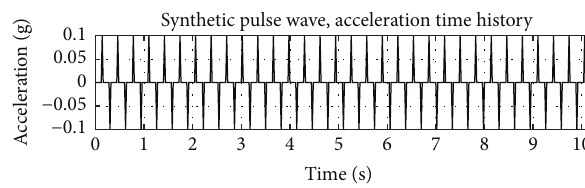
Figure 1: Acceleration time history of the selected pulse